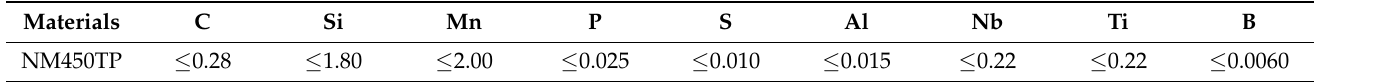
Table 1. Chemical compositions of NM450TP wear-resistant steel